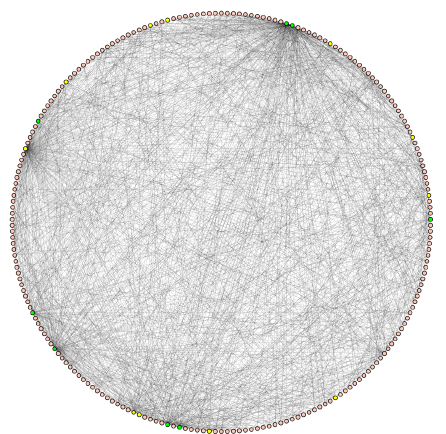
Figure 7. Countries are arranged alphabetically starting at the top and going counterclockwise. The green nodes are the G7 and G20 countries. The graph has 214 vertices, 1363 blue edges, the average blue degree is 12.7, the five highest blue degrees are 162 (China), 125 (United States), 96 (Germany), 66 (France) and Italy (61). The largest complete subgraph has eight vertices: Algeria, China, France, Germany, Italy, Spain, United Kingdom, and the United States, forming a K 8 . The largest independent set has 70 vertices, forming an I 70 .